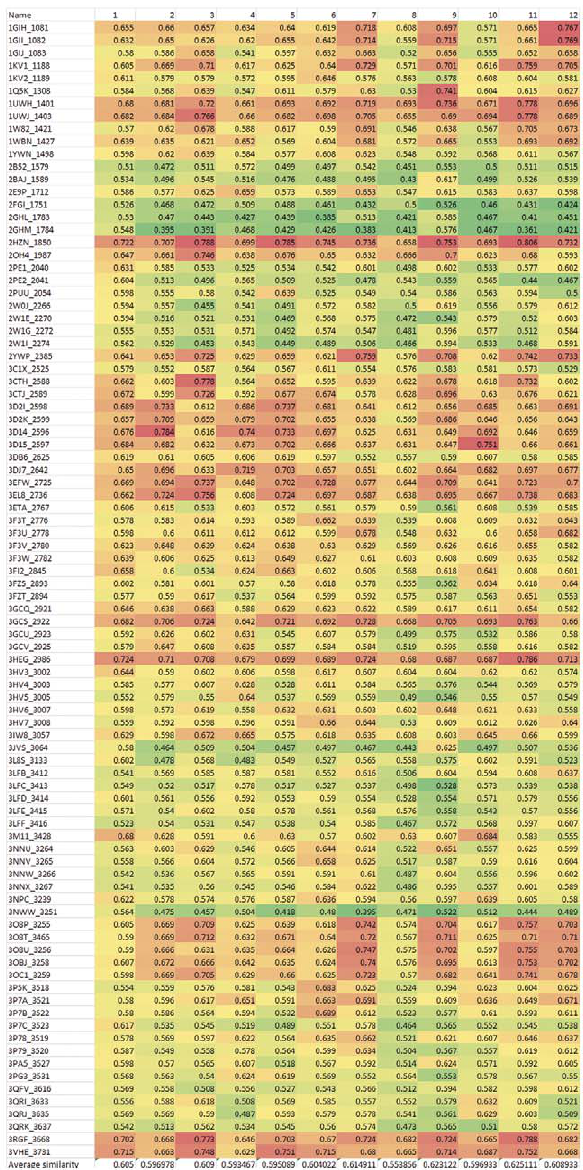
Figure 8. Heat map of twelve urea-based derivatives against a panel of 90 field templates representing urea –based kinases inhibitors complexed with their corresponding kinase enzymes as retrieved previously. The color codes used here is the red-yellow- green scale as indicative for decreasing similarity.